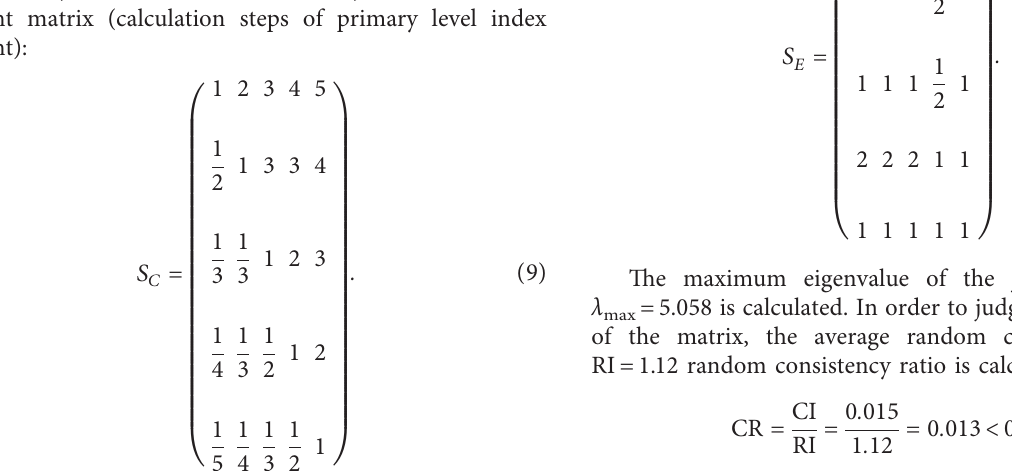
weight matrix (calculation steps of primary level index